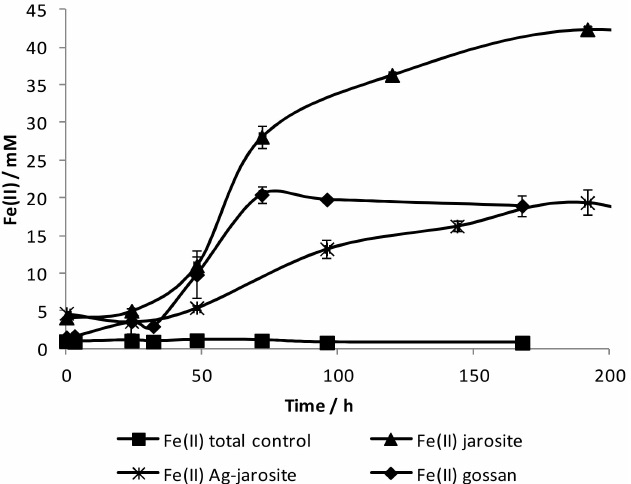
Figure 2. Fe(II) production by the natural consortium using different jarosite minerals as the sole iron source at 60 mM. All Fe(II) measurements were performed in duplicate by means of ferrozine method and standard deviation (n = 2) is shown for each data point. Error bars not visible are smaller than